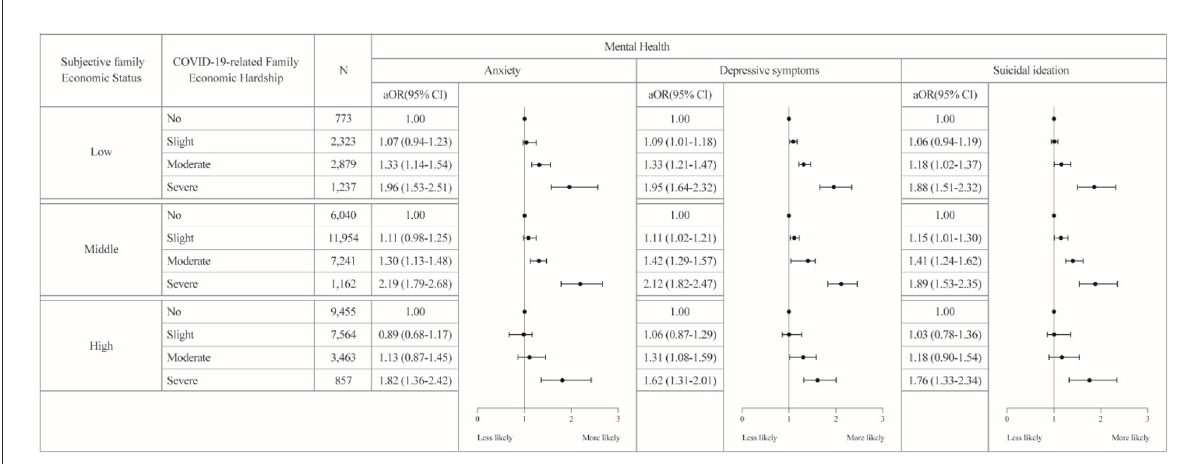
FIGURE1 Results of the stratified analyses by subjective family economic status ( N = 54,948). We performed stratified analyses of the association between COVID-19 related family economic hardship and mental health, stratified by subjective household economic status. We adjusted for sex,